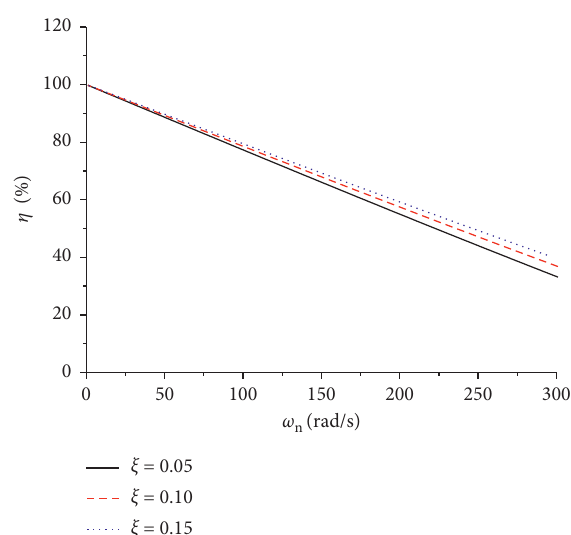
Figure 14: Vibration isolation rate curve of isolation device with angular